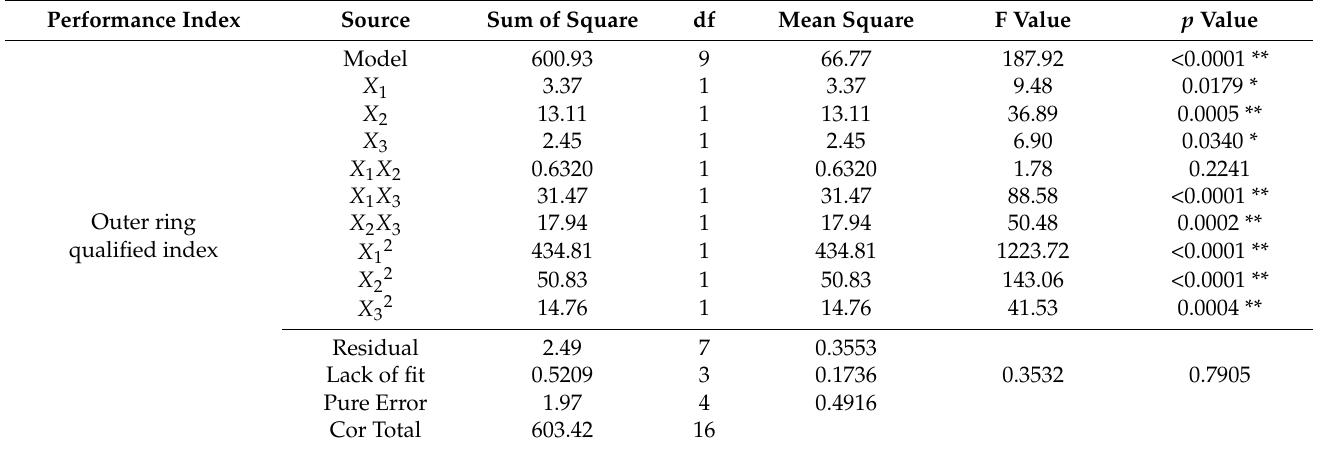
Table 6. Variance Analysis result of outer ring seed-metering performance